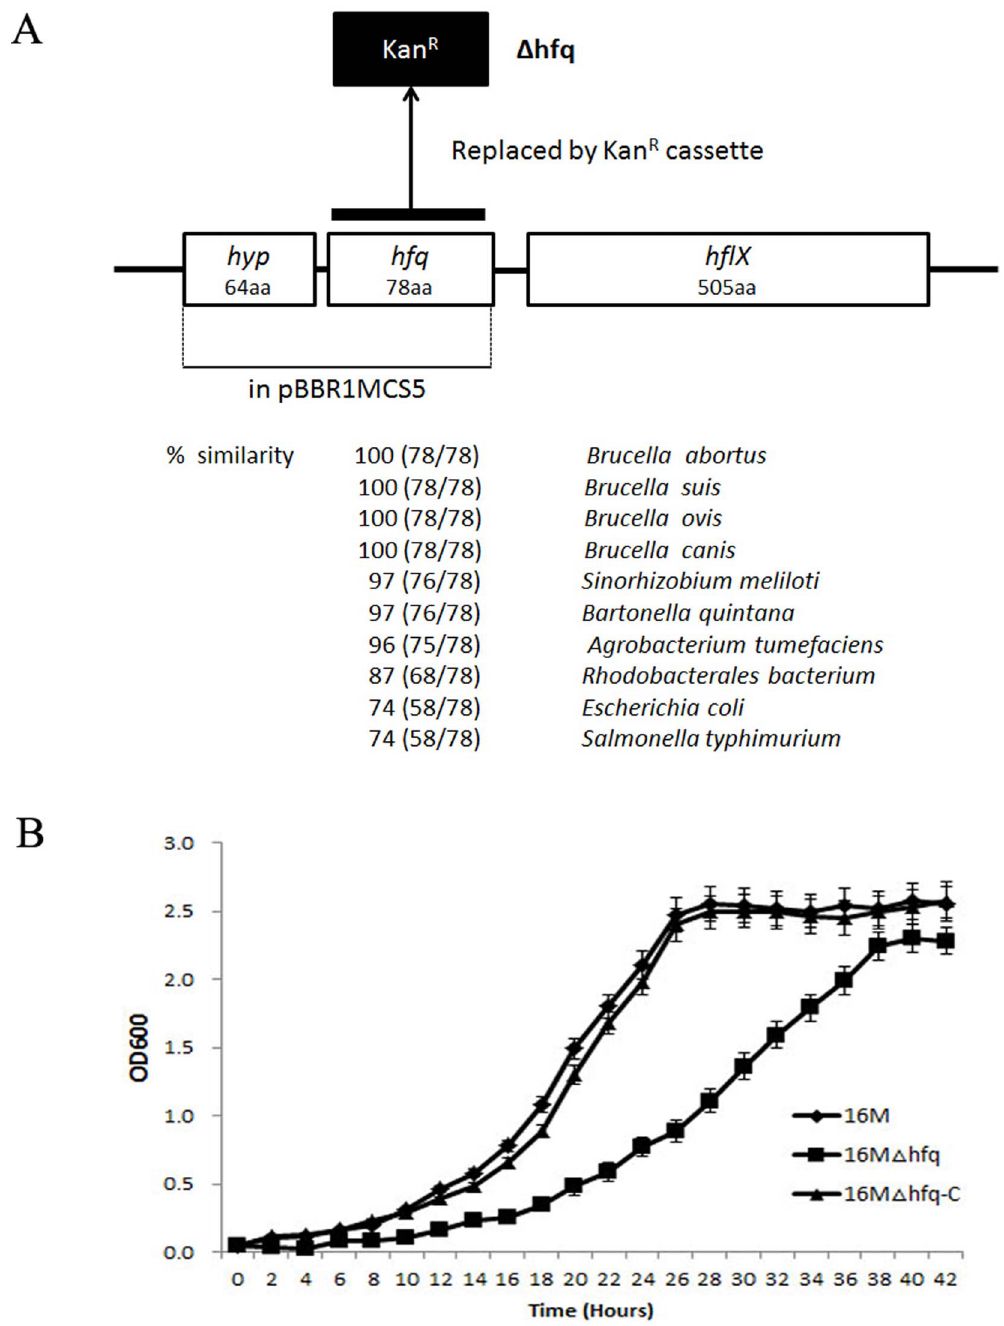
Figure 1. Details of the B.melitensishfq mutants and their growth characteristics. A. Structure of the hfq locus on B. melitensis 16 M chromosome I. In the D hfq, the coding region of hfq was deleted and replaced by a kanamycin resistance cassette. The coding region of hfq together with its native promoter cloned to pBBR1MCS5 yielding the complementation plasmid pBBR1-hfq. The percentage similarities were obtained using pairwise BLAST analyses that compared B. melitensis Hfq protein sequence with those of other Brucella spp ., alpha-proteobacteria, Escherichia coli , and Salmonella typhimurium . B. Growth characteristics of B. melitensis D hfq strain. B. melitensis wild-type, 16 M D hfq, and 16 M D hfq-C strain were cultured in TSB (pH7.0) at 37 u C, and the OD600 was measured at 2 h intervals. Each graph represents the mean of three independent biological replicates grown on three different days. The error bars represent the standard deviation (SD) of the optical density at each time point. doi:10.1371/journal.pone.0071933.g001 compared by 2-D gel electrophoresis. The typical proteome gel upregulated and 76 were found to be downregulated in the hfq maps of 16 M and 16 M D hfq were presented in Figure S1. The mutant when compared to the wild-type strain. The differentially expressed protein spots were picked from the preparative gels for relative volumes of protein expression were determined by imaging analysis, and 52 protein spots were found to be MALDI-TOF mass spectrometry identification. Among the spots